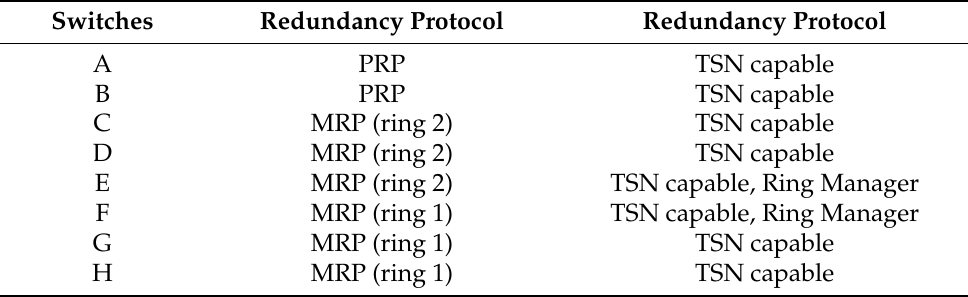
Figure 15. Network communication prototype using HSR. Table 2. Switches attributes in PRP network